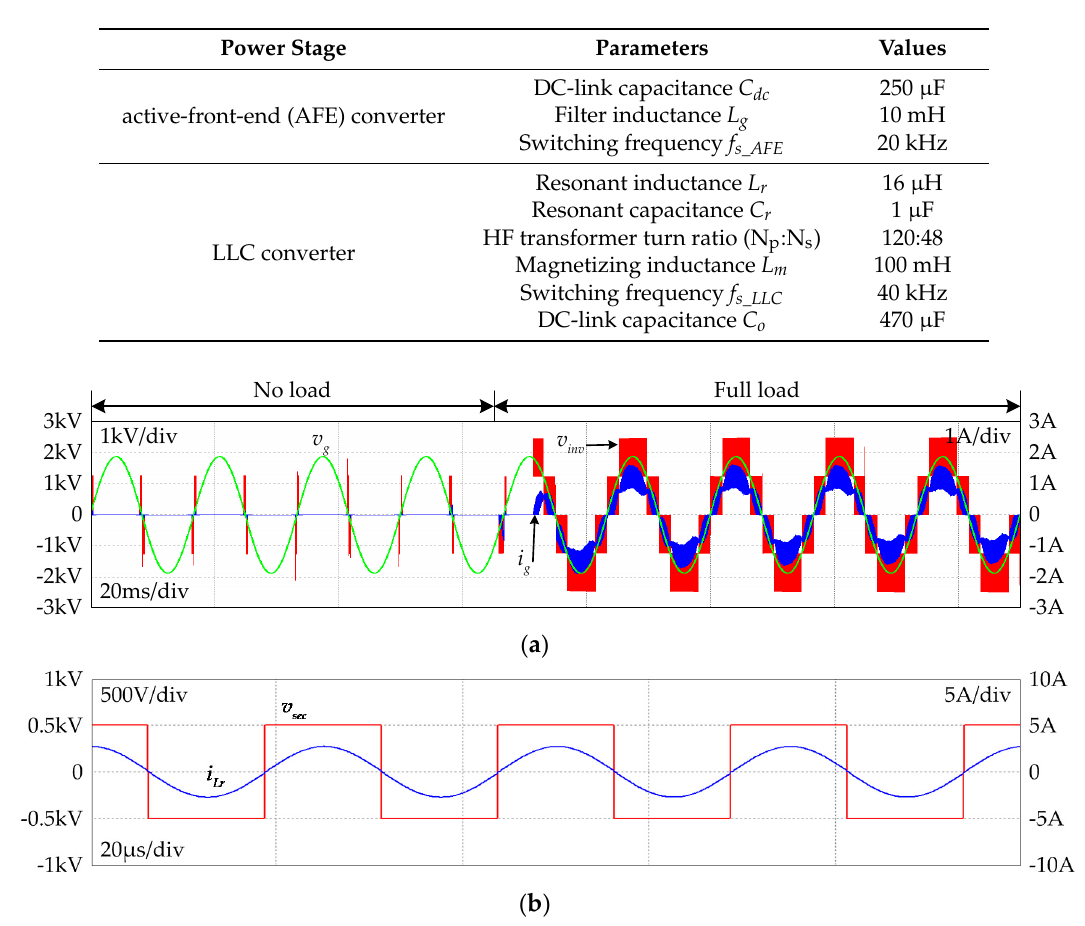
Table 3. Parameters for the simulation.